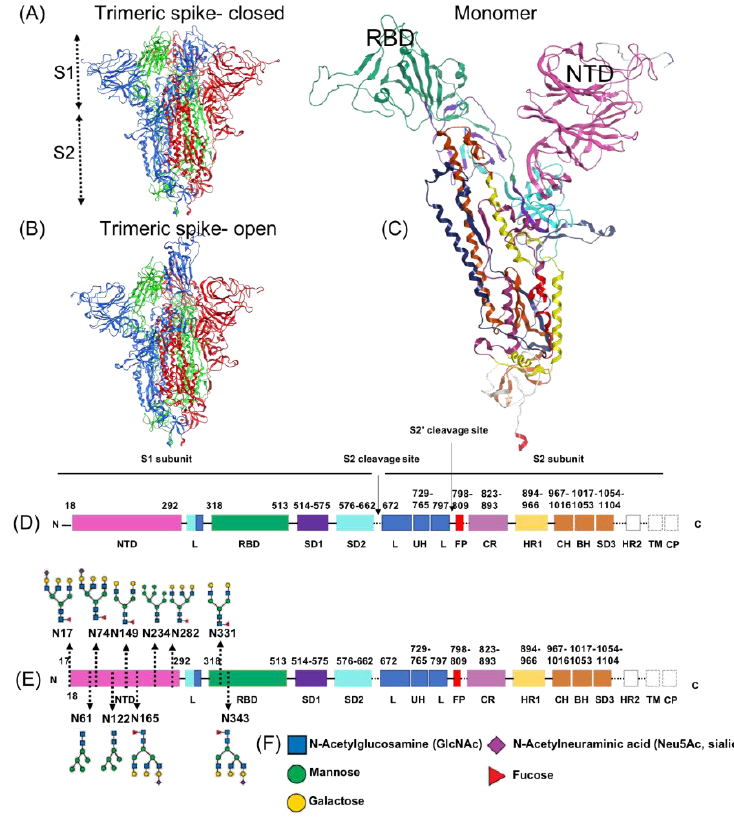
Figure 1. ( A , B ) Side view of SARS-CoV-2 spike protein trimer, open (PDB: 6VSB) and closed (PDB: 6VXX) configurations, respectively. Heptad repeats 2 (HR2), HR2 linker, transmembrane